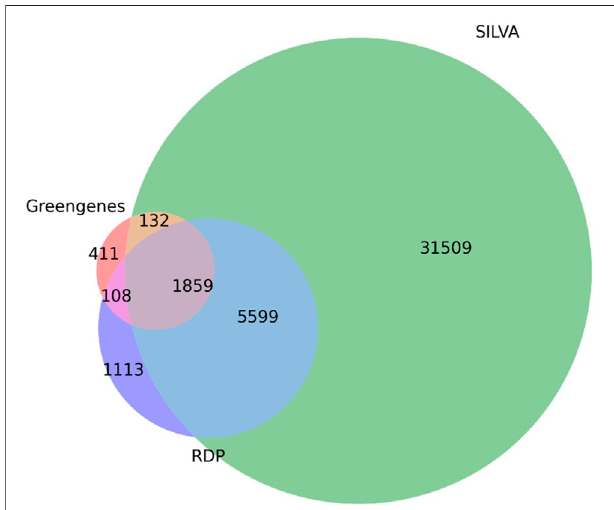
FIGURE 5 | Species distribution of RDP, SILVA, and Greengenes databases. The Venn diagram depicts the number of shared and unique species between the three